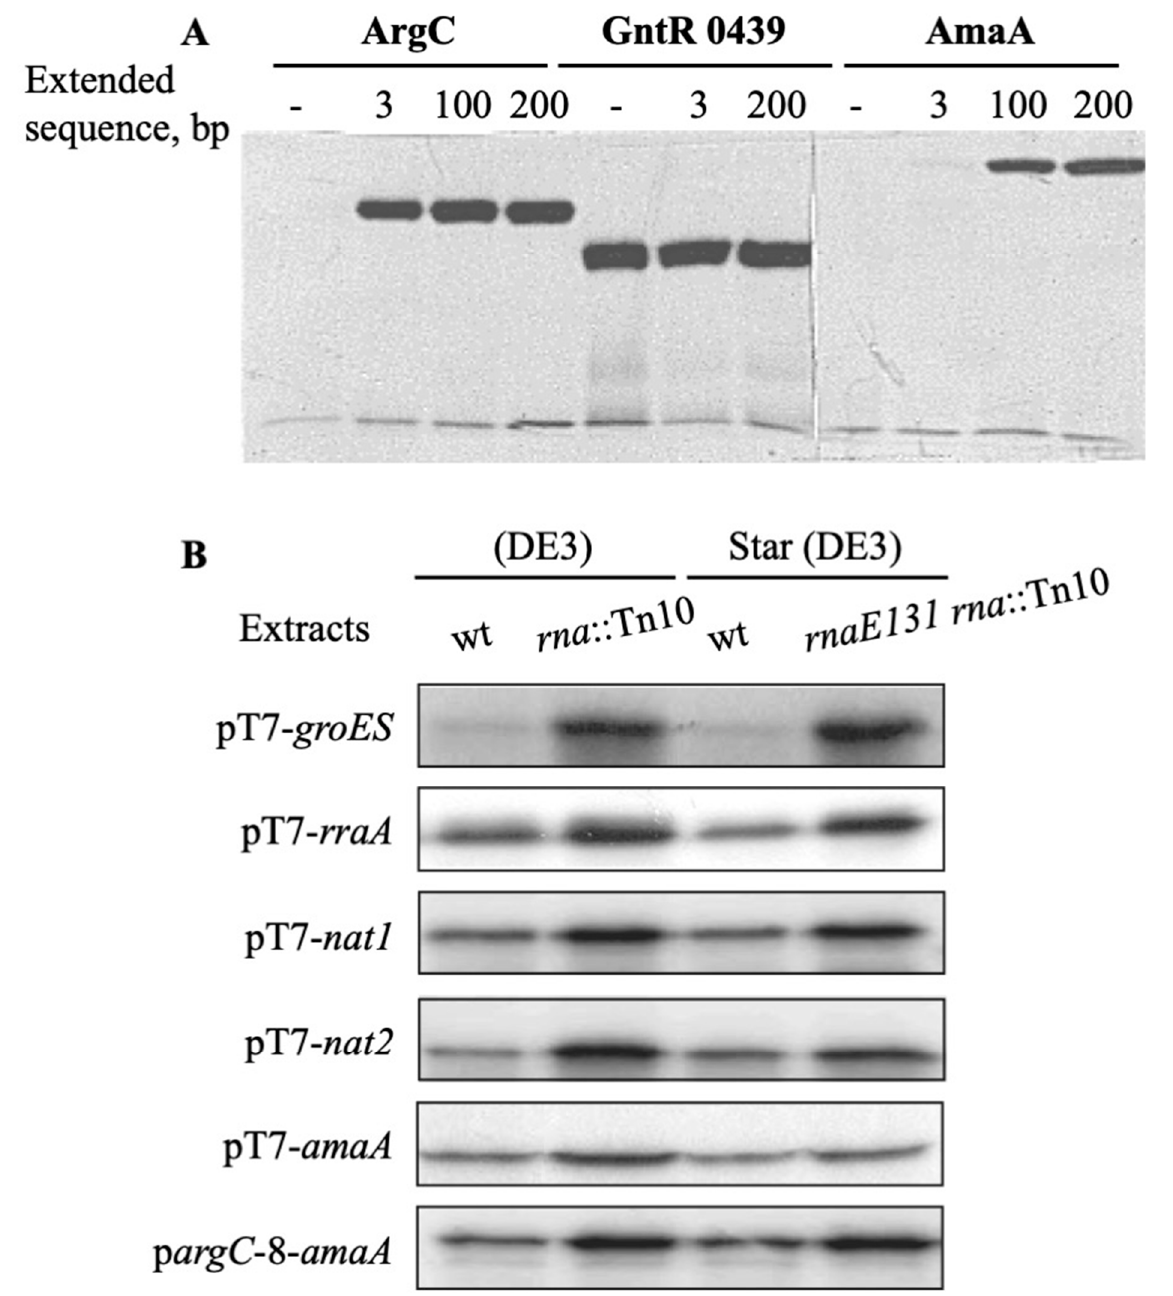
Figure 5. Effect of 3 (cid:48) -UTR extension on the p argC -promoted gene expression and protein production in wild-type and mutant RNase I ( rna ::Tn10) and RNase E ( rnaE131 ) strains of E. coli . ( A )—Lanes 1, 2, 3 and 4: G. stearothermophilus argC DNA, respectively, without and with an extended 3, 100 or 200 bp genomic sequence; lanes 5, 6 and 7: T. maritima gntR 0349 DNA, respectively, without and with an extended 3 or 200 bp genomic sequence; l anes 8, 9, 10 and 11: G. stearothermophilus amaA DNA, respectively without and with an extended 3, 100 or 200 bp genomic sequence. ( B )—The T. neapolitana groES , E. coli rraA , human nat1 and nat2 genes were expressed from pT7 promoter in pET ‐ pT7 ‐ x plasmids ( x —any gene); and G. stearothermophilus amaA gene was expressed on pETpT7 ‐ amaA and pETp argC ‐ amaA plasmids. Lanes 1–4, with S30 extracts of E. coli BL21 (DE3), E. coli BL21 (DE3) rna ::Tn10, E. coli BL21 Star (DE3) rnaE13 and E. coli BL21 Star (DE3) rna ::Tn10 rnaE131 strains, respectively. The sample volume used for analysis with pargC-8-amaA was twice that of plasmid pT7-8-amaA. Similar results were obtained in two assays.